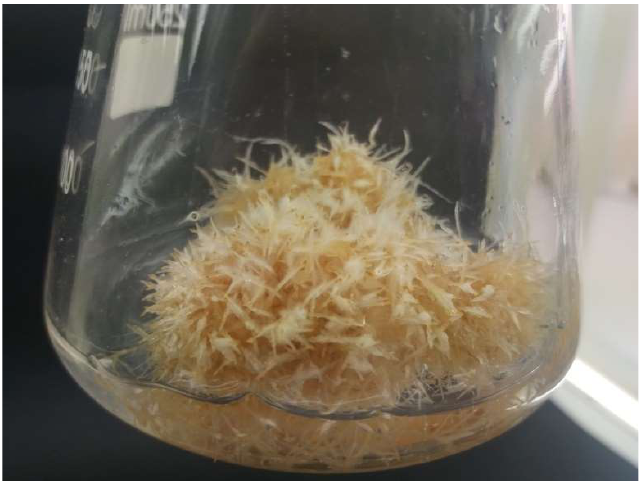
Figure 3. Hairy roots of K-1 line growing in liquid DCR I medium supplemented with L-glutamine 500 mg/L, 30 g/L sucrose.